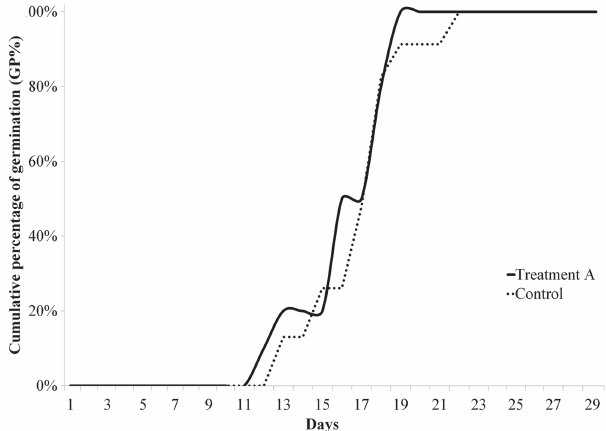
Fig. 5. Germination Speed Index (GSI) of Montrichardia linifera ’s intact seeds from Lithodoras dorsalis ’ stomachs (Treatment A); and from the forest (Treatment C - Control) at the Amazon River mouth, Brazil, from July 2010 to June